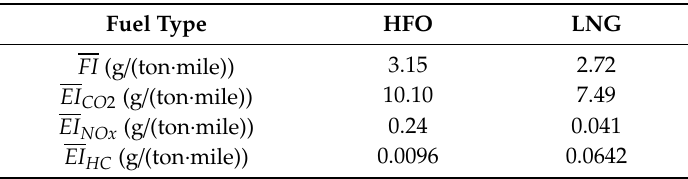
Table 7. Average fuel and emissions indexes of the whole